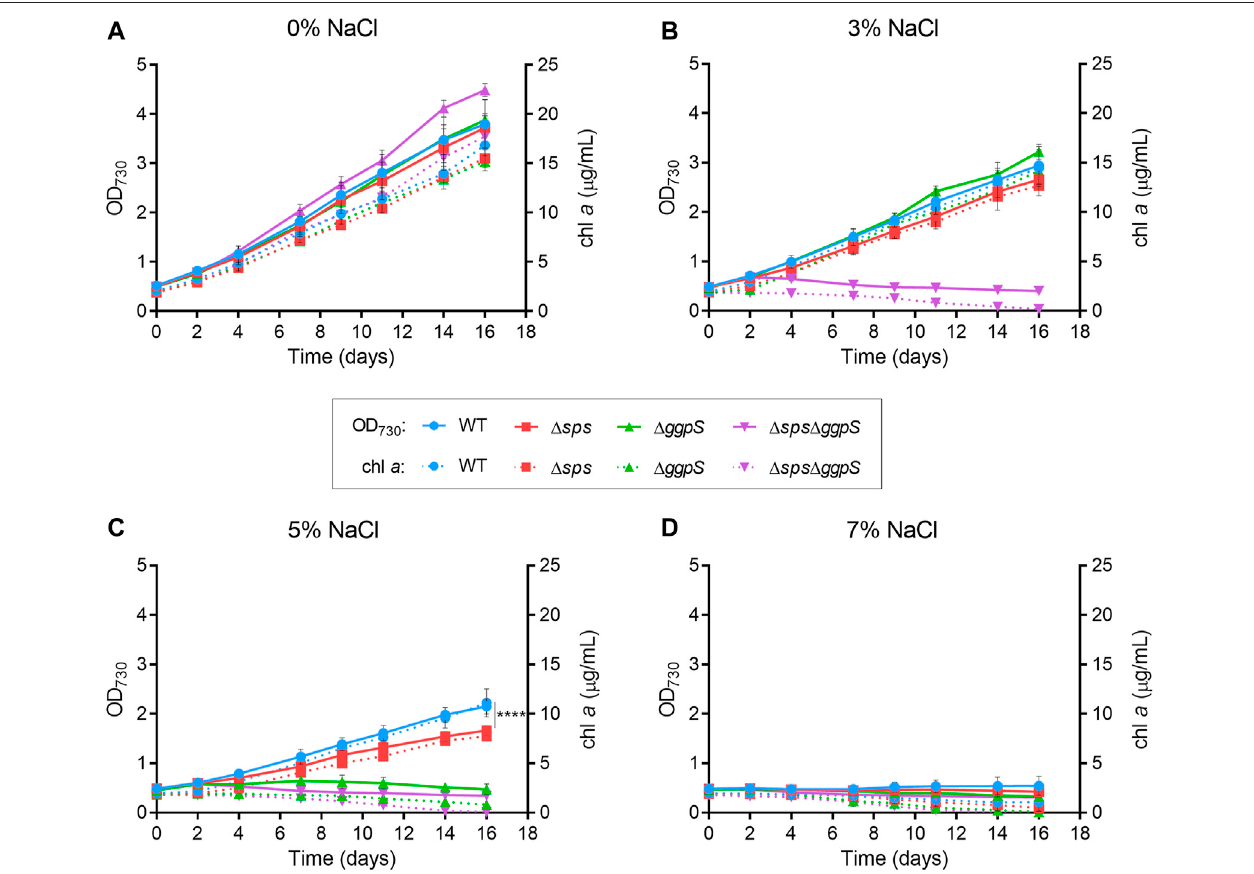
FIGURE1| Growthcurvesof Synechocystis wild-type(WT)and Δ sps , Δ ggpS and Δ sps Δ ggpS mutantsinBG11 (A) orBG11supplementedwith3% (B) ,5% (C) or 7% (D) (wt/vol) NaCl. Cultures were grown at 30 ° C with orbital shaking (150 rpm) under a 12 h light (25 μ E/m 2 /s)/12 h dark regimen. Growth was monitored by measuringopticaldensityat730 nm(OD 730 ),andchlorophyll a (chl a )(fullanddottedlines,respectively).Errorbarscorrespondtostandarddeviationsfromatleastthree biologicalreplicateswithtechnicalduplicates.Statisticalanalysiswasperformedusingatwo-wayANOVA,andasigni fi cantdifferenceintermsofOD 730 isidenti fi ed by **** ( p ≤